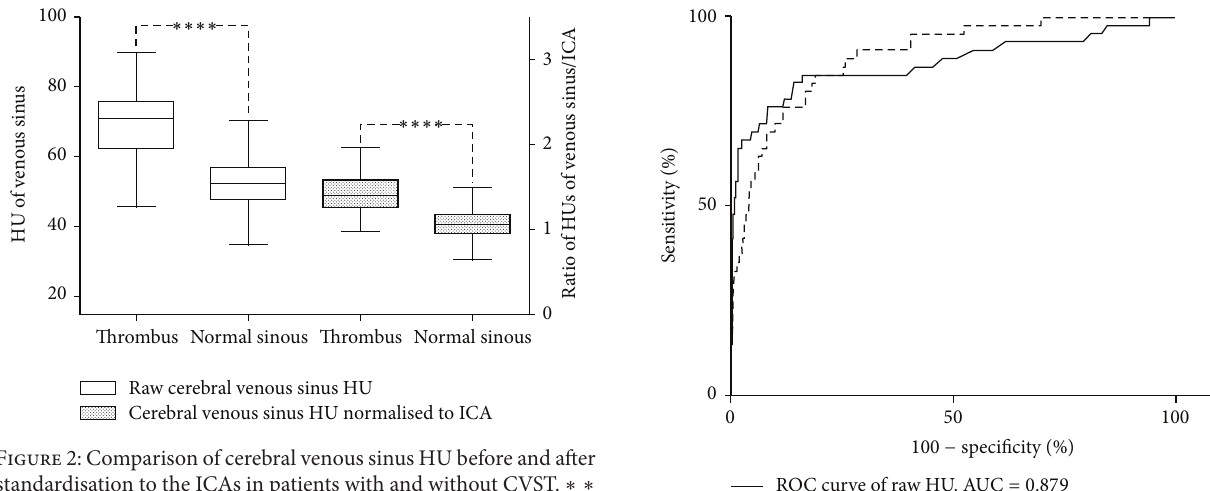
ROC curve of raw HU. AUC = 0.879 ROC curve of standardised HU. AUC = 0.899 Figure 3: ROC curves comparing the difference between raw HU and standardized